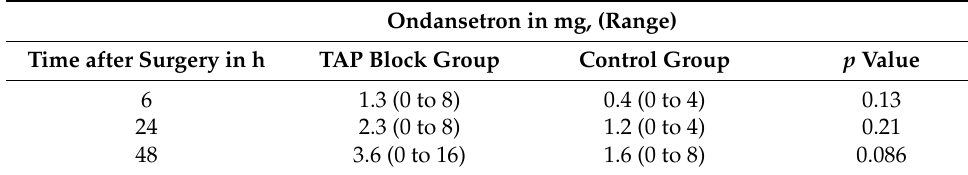
Table 3. Postoperative consumption of antiemetic drugs. Ondansetron in mg, (Range) Time after Surgery in h TAP Block